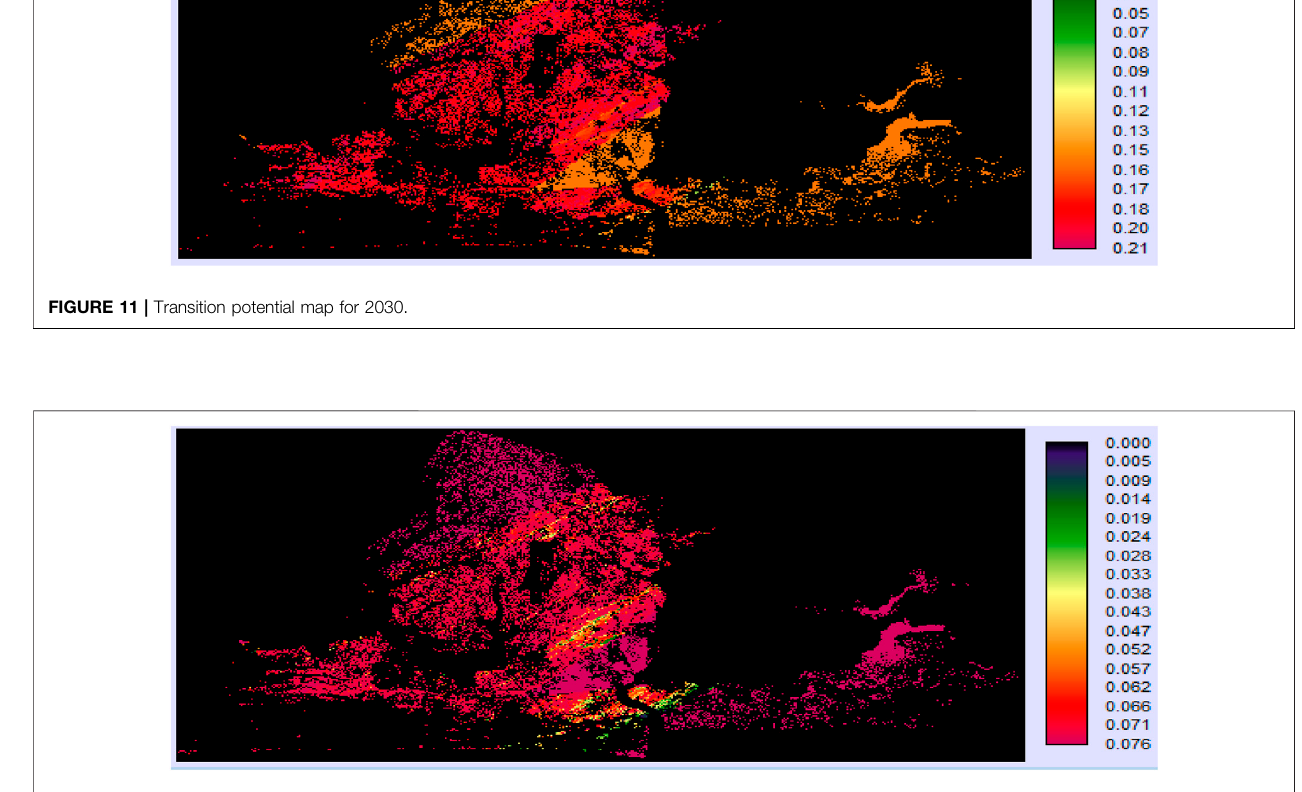
FIGURE 12 | Transition potential map for